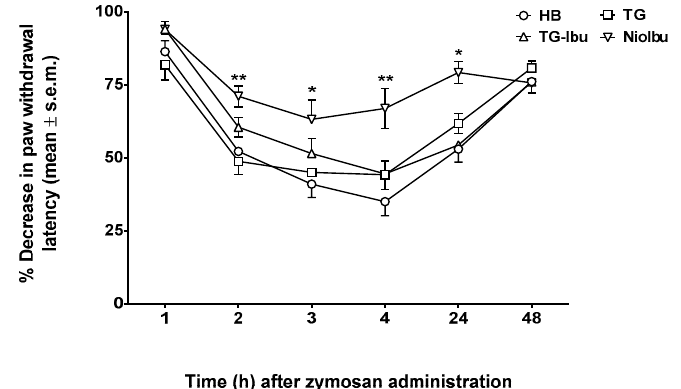
Figure 5. Effects of Hepes buffer (HB), the unstructured surfactant formulation (TG), the unstructured surfactant formulation with the same Ibuprofen (IBU) concentration (TG-Ibu), and TW20-Gly loaded with IBU (NioIbu) on zymosan-induced hyperalgesia. * is for P < 0.05 and ** is for P < 0.01 versus TG. N = 10.